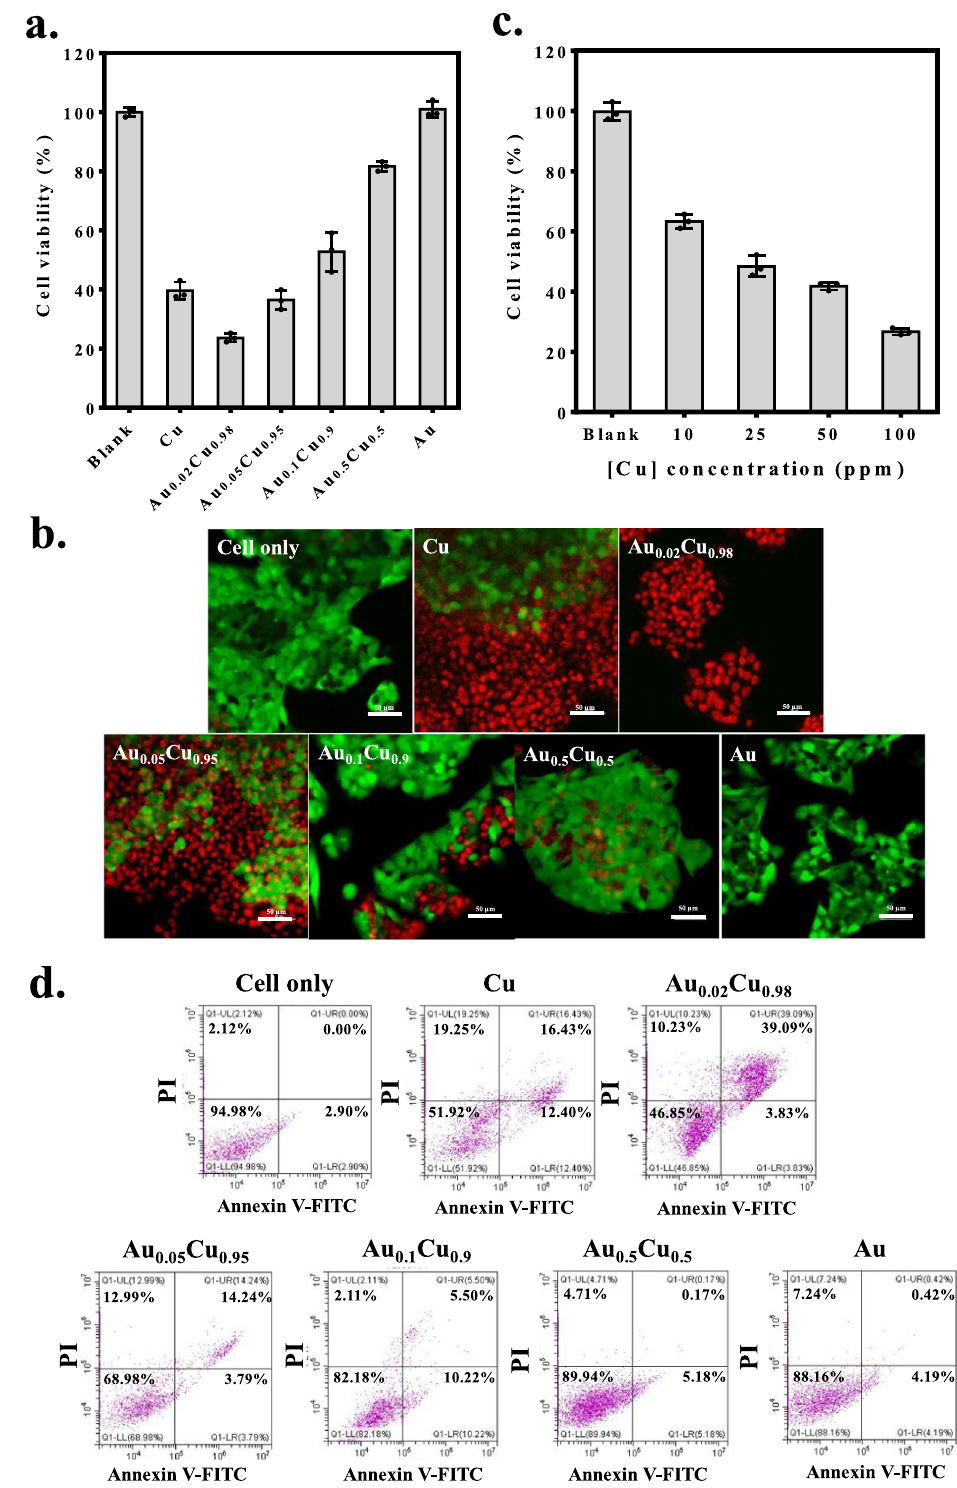
Fig. 5 | In vitro studies of Cu@SA, Au@SA, and Au/Cu0@SA nanocubes. a The cytotoxicity study of Cu@SA, Au@SA, and Au/Cu 0 @SAnanocubes with HepG2- Red-FLuc liver cancer cells by using MTT assay through 100ppm in Cu con- centration. b Live (green color) and dead cells (red color) stained with fl uorescent green dye (Calein-AM) and red dye (propidium iodide), respectively, for cancer cellstreatedwithCu@SA,Au@SA,andAu/Cu 0 @SAnanocubes(onerepresentative